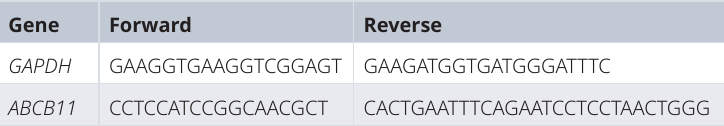
Table 3. Oligonucleotide primers used for real time